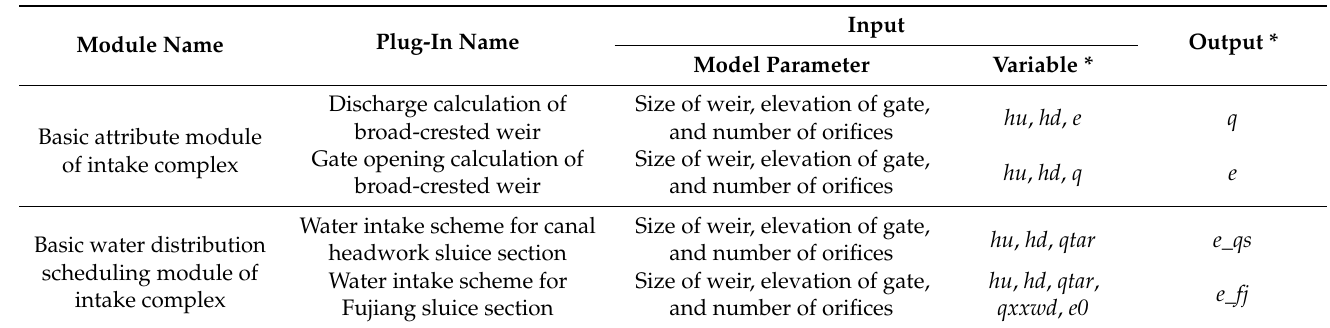
Table 3. Plug-in partition table for the basic water distribution dispatching model of the intake